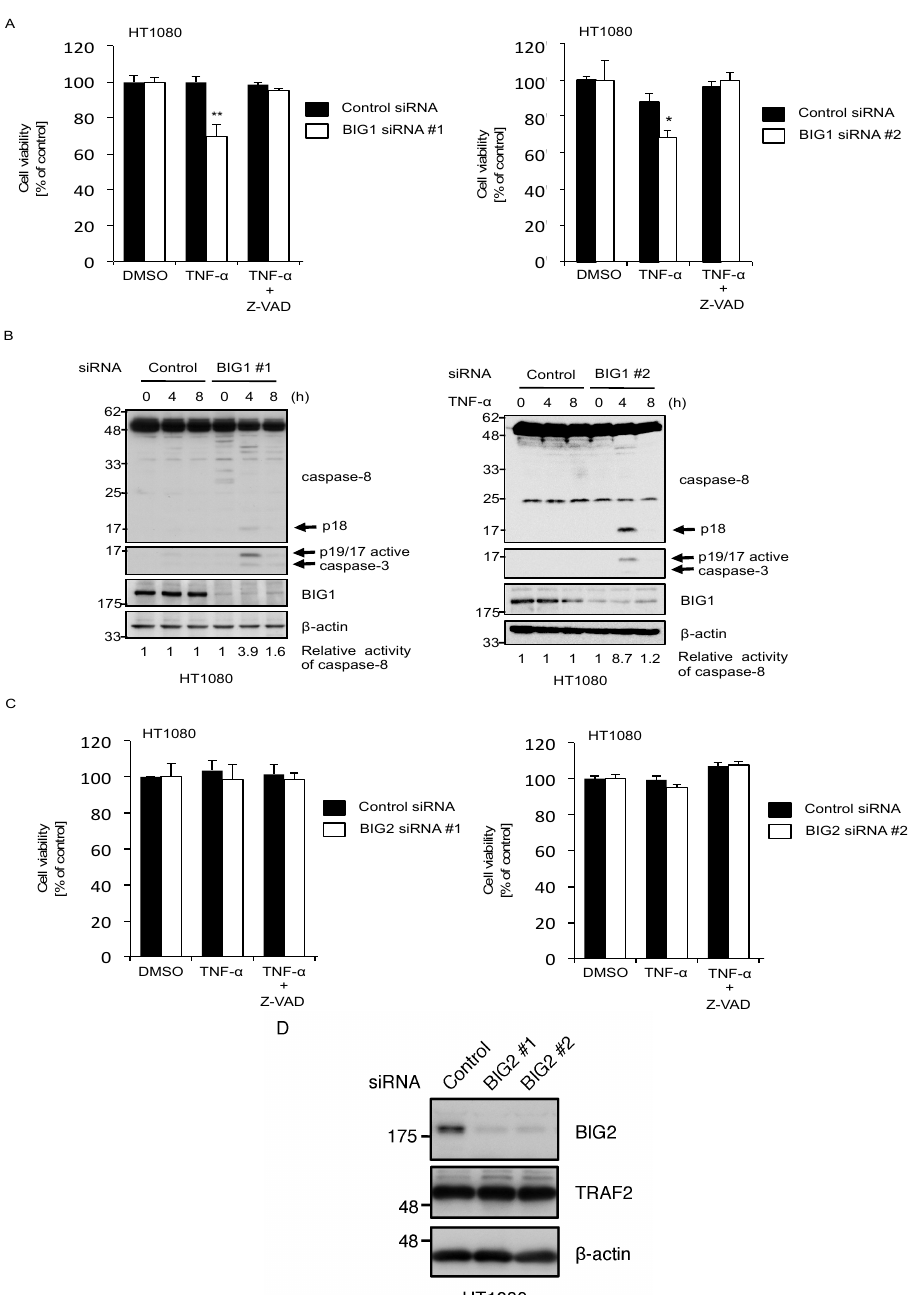
Figure 4. Knockdown of BIG1 increases sensitivity to TNF- α -induced apoptosis. ( A ) HT1080 cells were transfected with siRNA for negative control or BIG1, and treated 72 h later with ± 50 ng/mL of TNF- α for 24 h. DMSO (dimethy sulfoxide) was used as vehicle control. Cell viability was monitored with the PMS/MTS assay, normalized to untreated control cells and expressed as mean ± SEM ( n = 3). Statistical significance was tested using an unpaired Student’s t -test (vs. control cells); * p < 0.05, ** p < 0.01, (vs. control cells); ( B ) HT1080 cells were transfected with siRNA for negative control or BIG1. After 72 h, the cells were treated with 100 ng/mL TNF- α for the indicated periods. Cell extracts were subjected to immunoblotting with the indicated antibodies. The relative activity of caspase-8 was quantified using ImageJ software; ( C ) HT1080 cells were transfected with siRNA for negative control or BIG2, and treated 72 h later ± 50 ng/mL of TNF- α for 24 h. DMSO was used as vehicle control. Cell viability was monitored with the PMS/MTS assay, normalized to untreated control cells and expressed as mean ± SEM ( n = 3); ( D ) HT1080 cells were transfected with siRNA for negative control or BIG2. After 72 h, cell extracts were subjected to immunoblotting with the indicated antibodies.